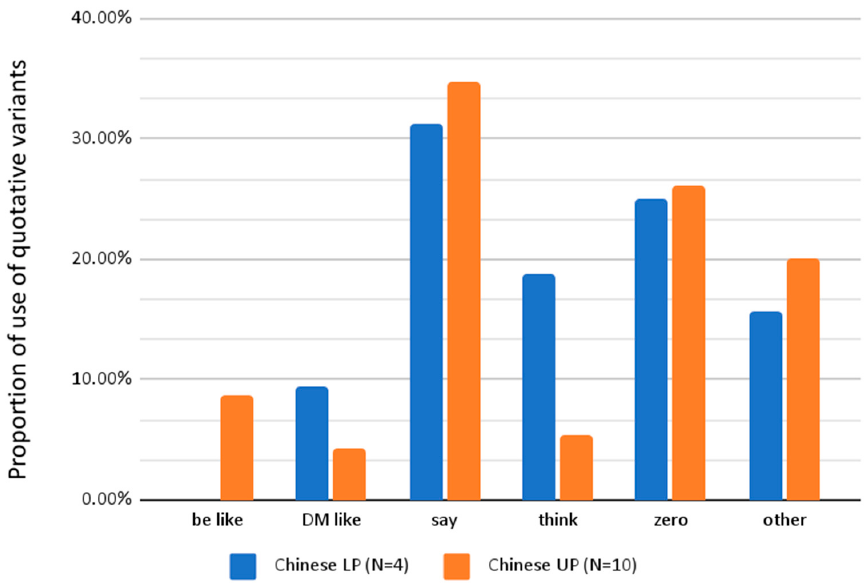
Figure 4. Comparison of most frequently used quotative variants by proficiency group in the Chi- nese L2